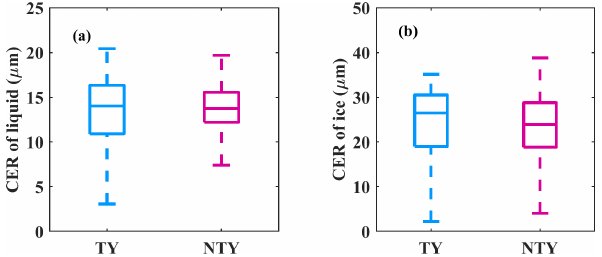
Figure 15. (a) Liquid and (b) ice particles cloud effective radii (CER; in micrometers, µm) values for typhoon (TY) and non- typhoon (NTY) rainfall.